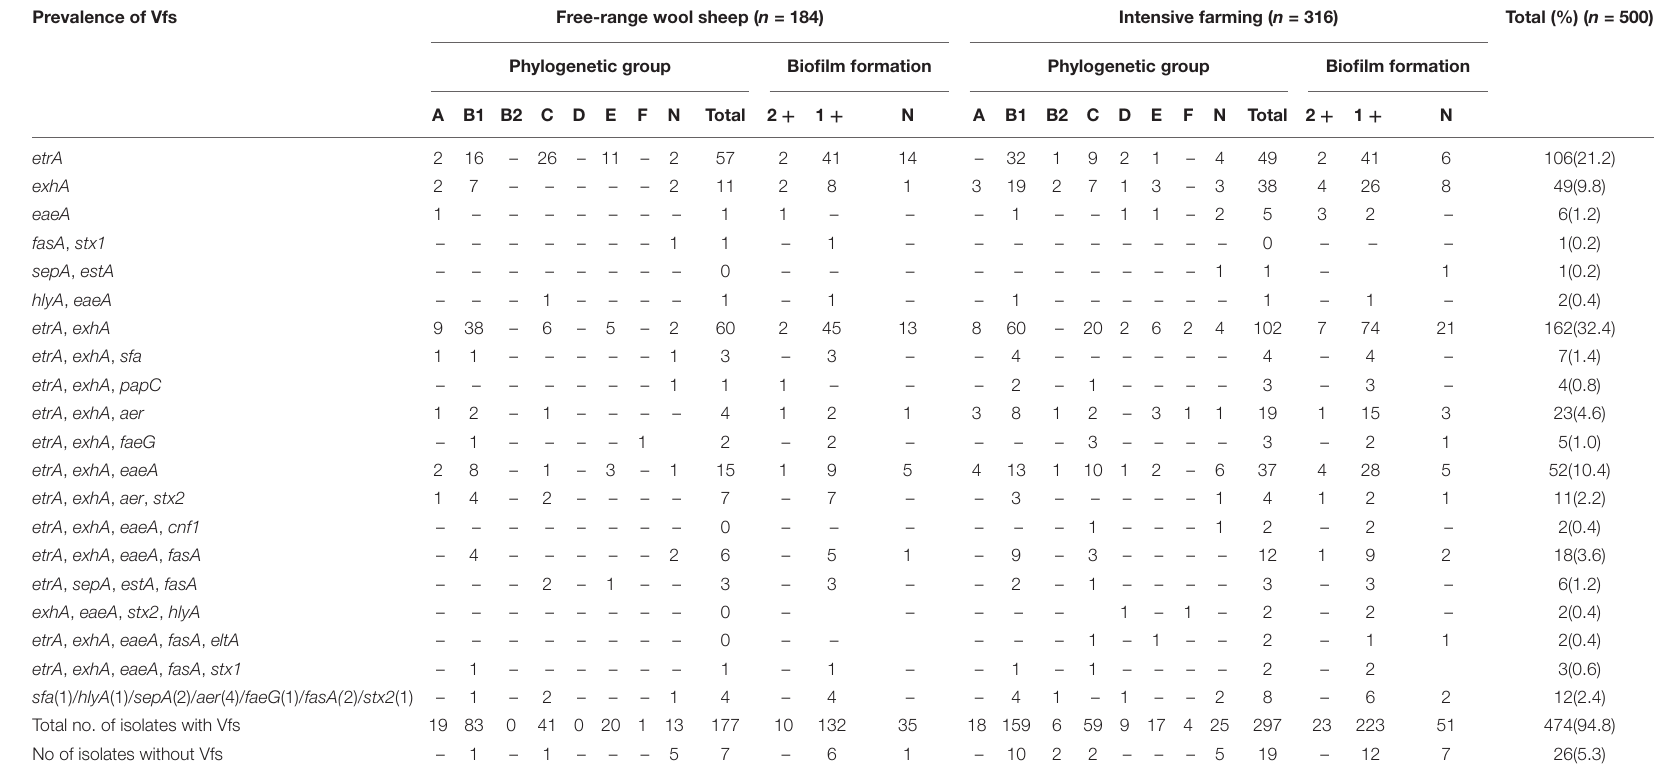
TABLE 4 | Distribution of virulence genes in relation to phylogenetic